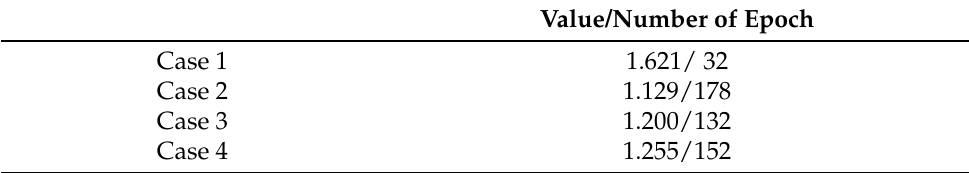
Table 2. Minimum validation